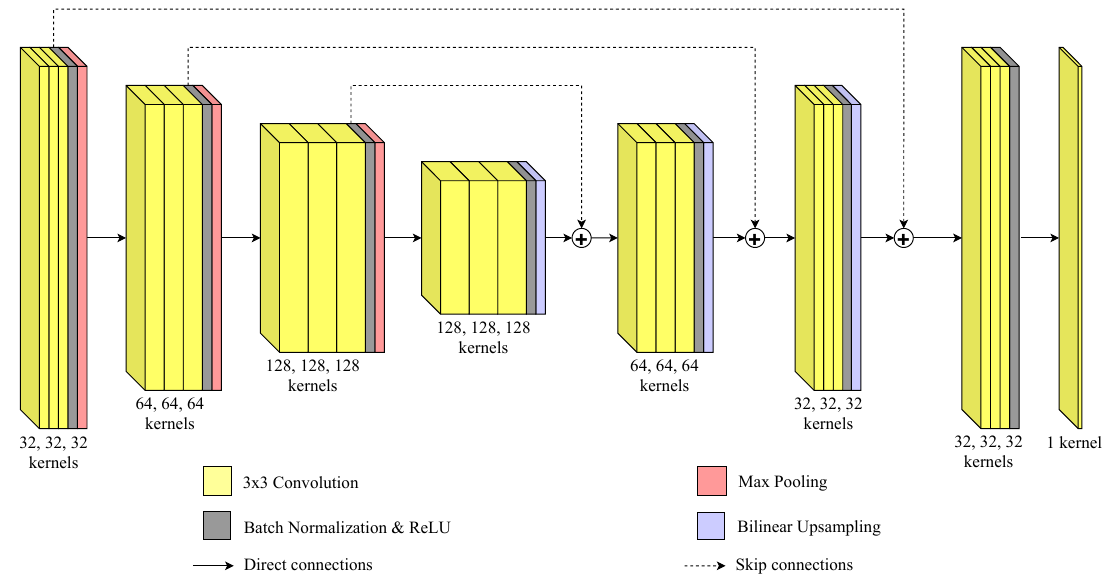
Figure 1. Network